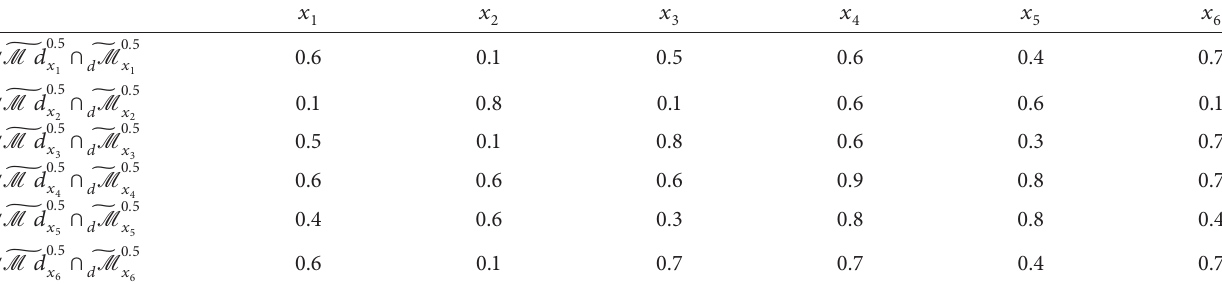
Table 7: The result for ∨ 􏽧 M d β